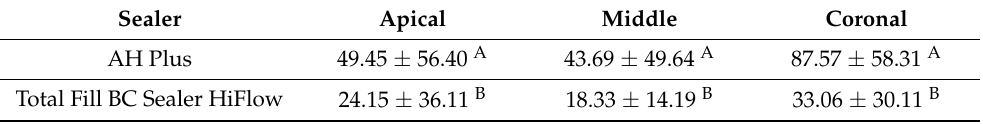
Table 1. Means and standard deviations for sealer penetration ( µ m) of AH Plus and Total Fill BC Sealer HiFlow in the apical, middle and coronal portion of the